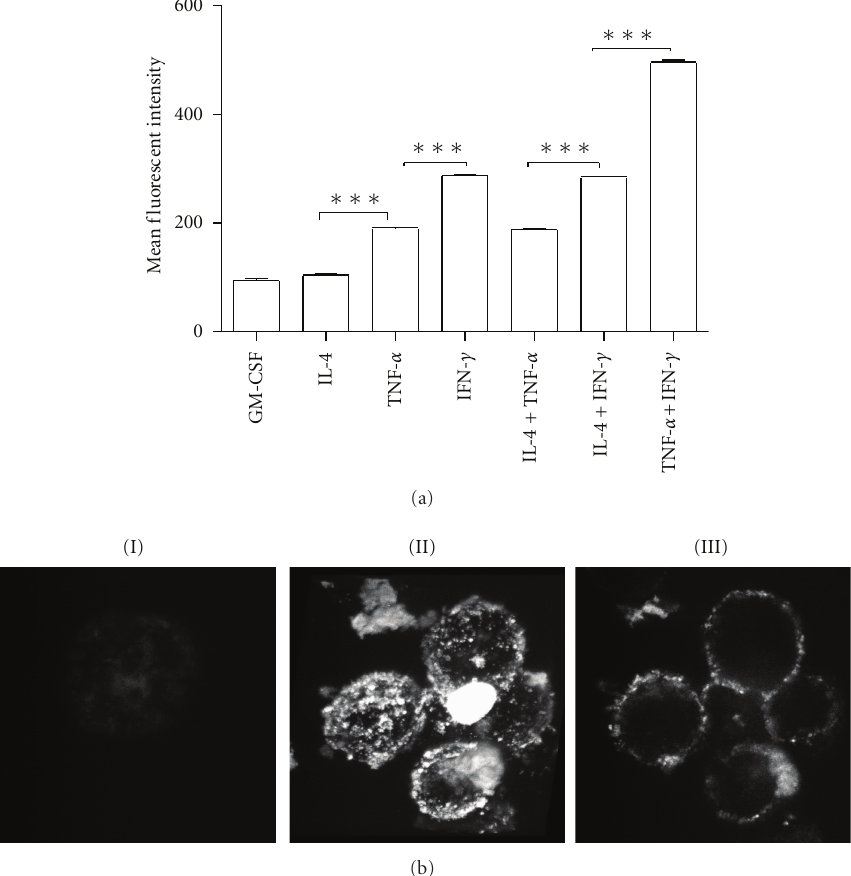
Figure 3: The ability of cytokine-treated MTHCs to process DQ-OVA antigen in vitro : (a) the mean fluorescent intensity of FACS analysis shows that MTHCs treated with di ff erent cytokines have the di ff erent abilities to process DQ-OVA antigen. Data are expressed as the mean ± SE of three independent experiments. ∗∗∗ P < 0 . 001. (b) The representative images of confocal microscopy show the process of DQ-OVA by MTHCs treated with IFN- γ + TNF- α : (I) MTHCs cultured with GM-CSF only scarcely show any DQ-OVA fluorescent signal on the cell surface. (II) MTHCs treated with IFN- γ + TNF- α have strong DQ-OVA signals on the cell surfaces. (III) The Z-stack image of